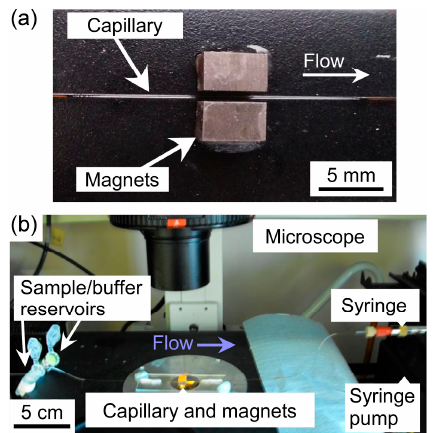
Figure 2. Setup of the microfluidic device: ( a ) photograph of a fused silica capillary located in the 1 mm gap between two 4 ˆ 4 ˆ 6 mm 3 NdFeB magnets that were fixed to a glass microscope slide; and ( b ) photograph of the glass microscope slide, holding the capillary and magnets, on the sample stage of an inverted fluorescence microscope. Samples, reagents and buffer solutions were introduced into the capillary from reservoirs via a syringe pump in withdrawal